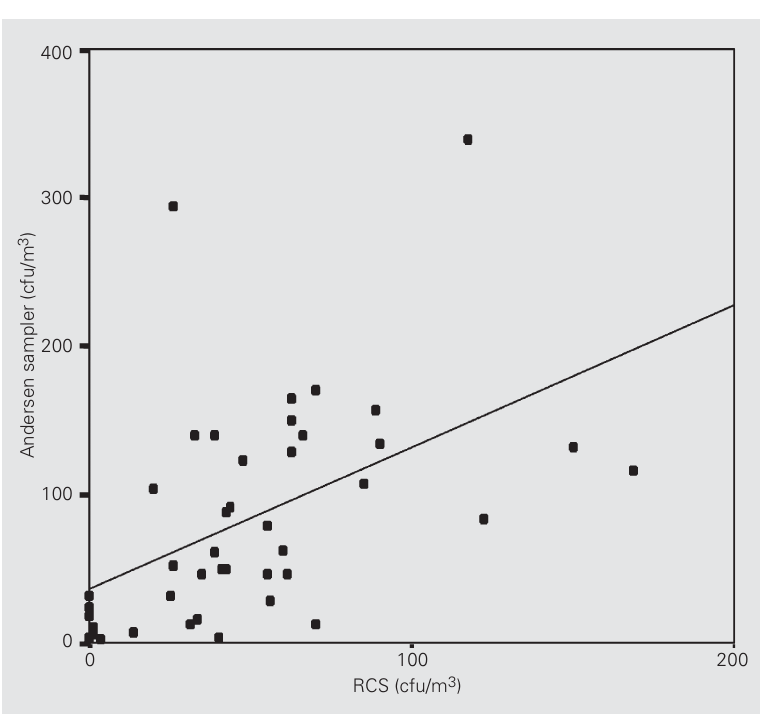
Figure 1. Correlation between fungal spore levels determined by measurement with the N-6 Andersen sampler and the Reuter centrifugal air